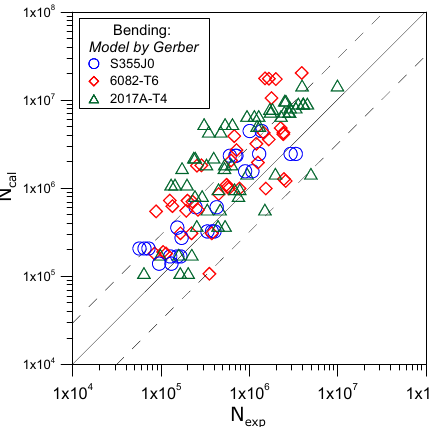
Figure 3. Comparison of calculated and experimental fatigue life by applying Gerber’s model for three tested materials subjected to bending.